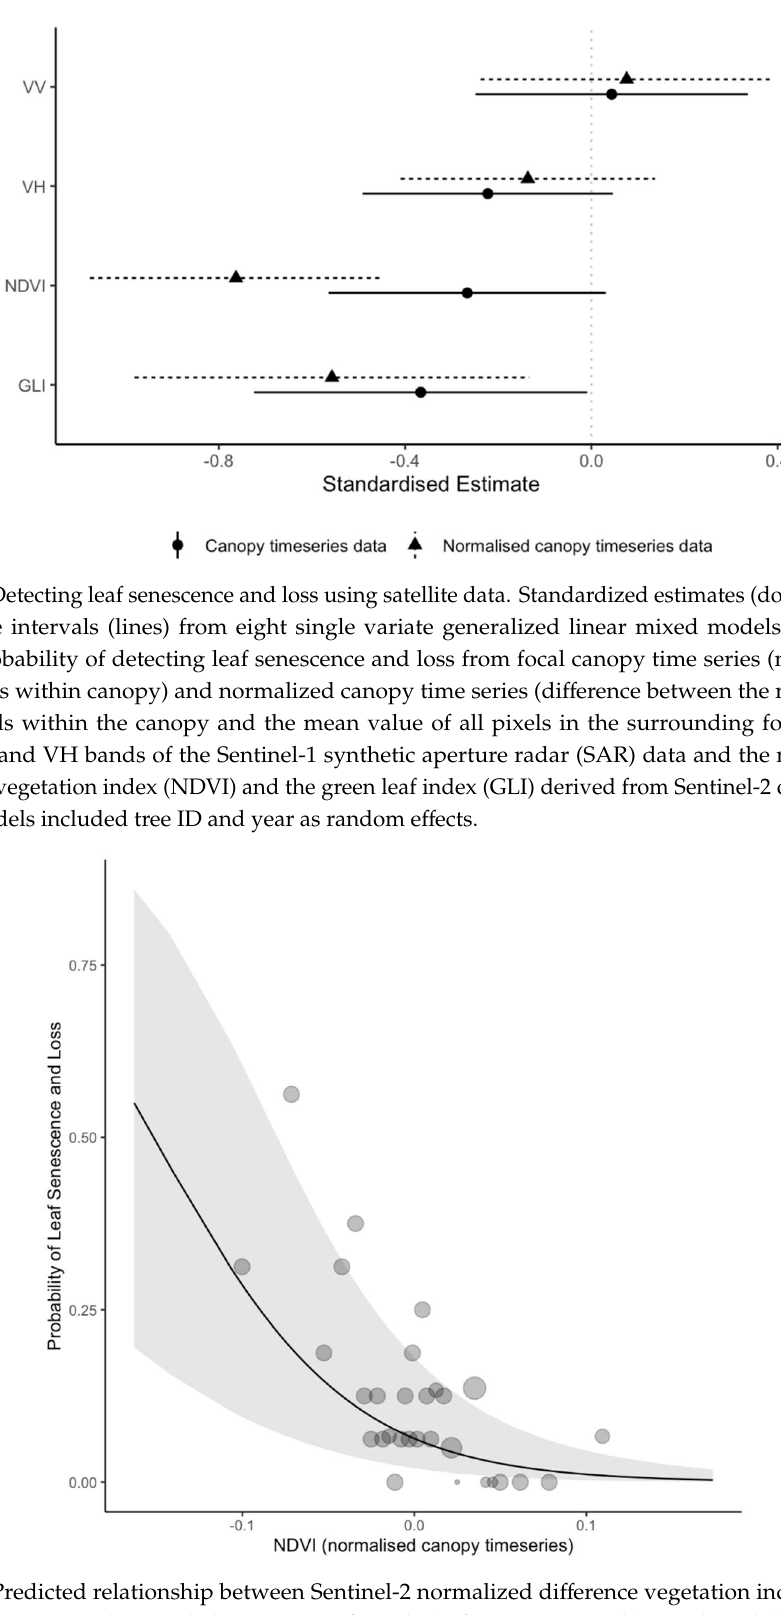
Figure 5. Predicted relationship between Sentinel-2 normalized difference vegetation index (NDVI) canopy deviation and ground observations of Moabi leaf senescence and loss. The solid line shows the fixed effect prediction from the generalized linear mixed model (binomial), the grey ribbon shows the 95% confidence intervals of the prediction, and the translucent dots show the raw data, binned in intervals along the x-axis. The mixed model included tree ID and year as random effects.